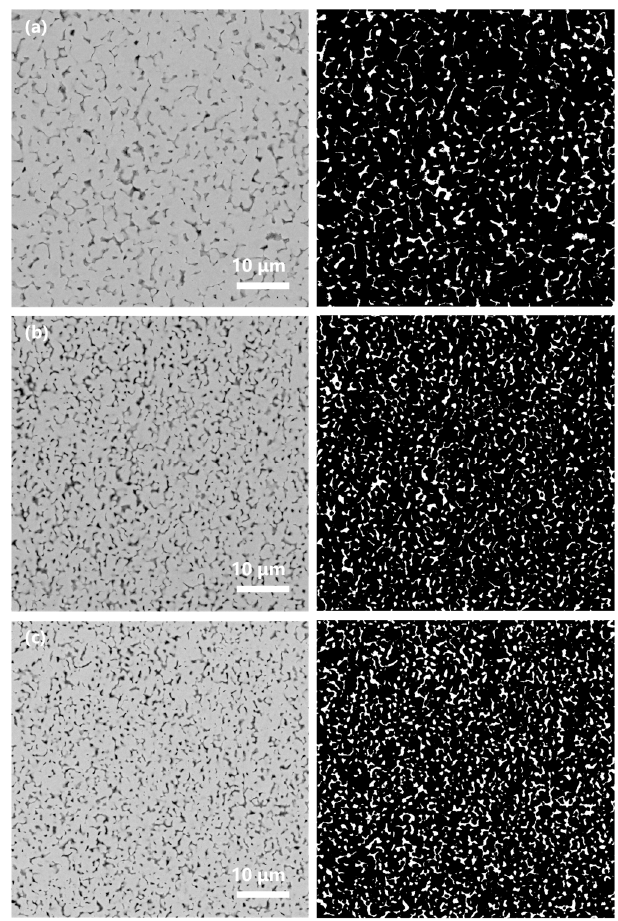
Figure 10. SEM images of cross-sections of the sintered silver nanowire film prepared with similar diameters but different lengths of silver nanowires. The average lengths are ( a ) 34 μ m, ( b ) 18 μ m, and ( c ) 8 μ m, respectively. The images in the right column were reinforced by Image Pro Plus.